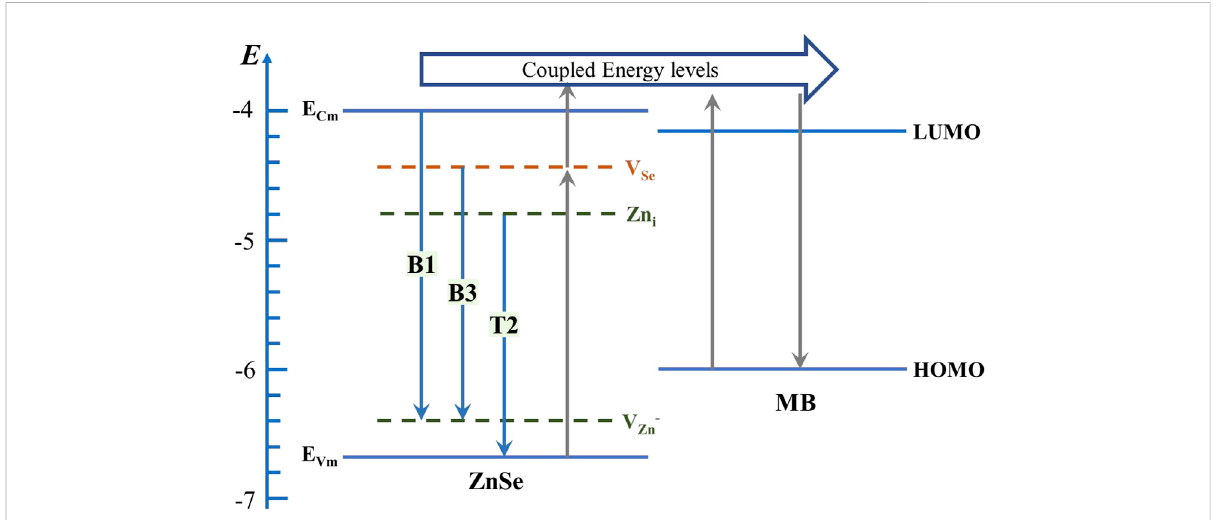
FIGURE 7 Energy-leveldiagrampresentingtheSERSabilitymechanismonZnSemicrostructuresusingmethyleneblue.Abbreviation:V Zn −